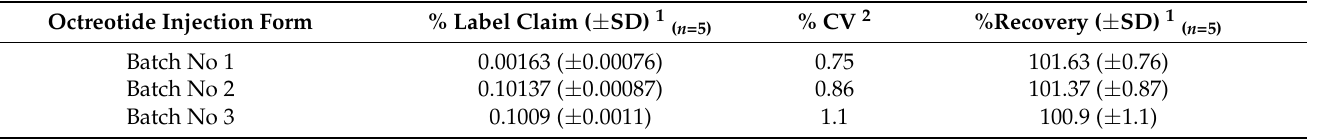
Table 3. Results of the HILIC-FL method for the quantitation of octreotide in injection forms. Octreotide Injection